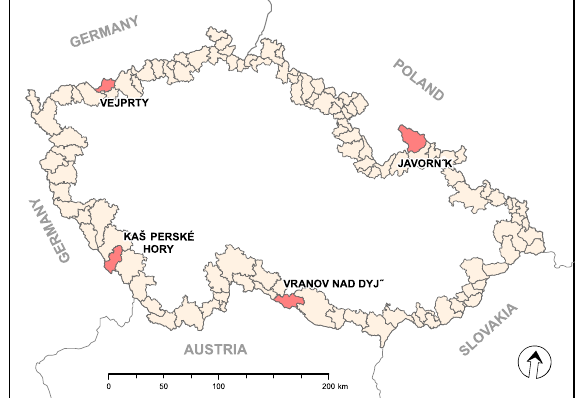
Fig. 2 Location of micro-regions under the